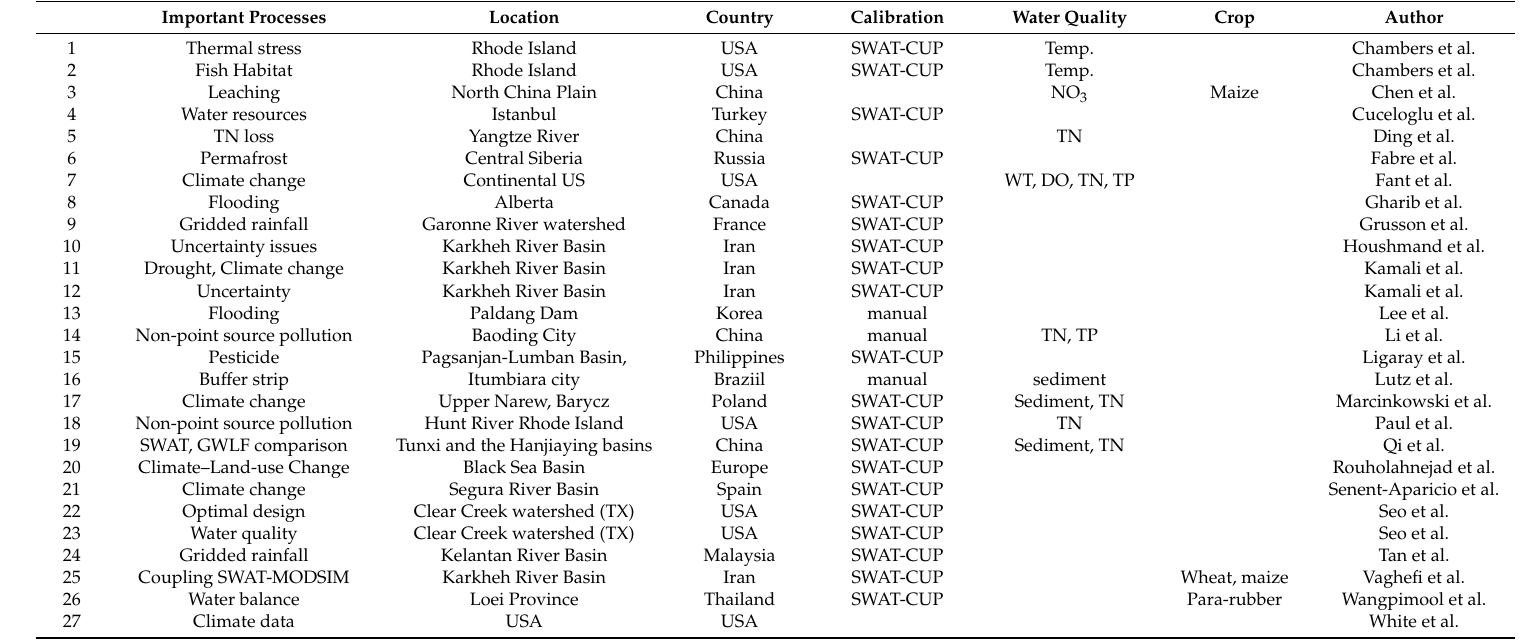
Table A1. Summary of the papers published in the special